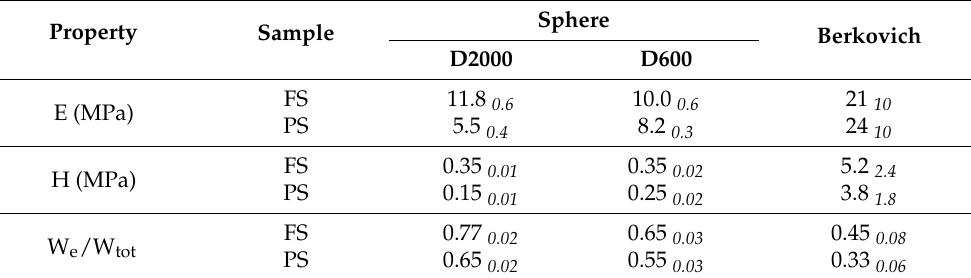
Table 3. Average values and standard deviations of elastic modulus, hardness, and elastic-to-total work ratio determined from indentation tests with spherical and Berkovich tips, using the CSM method. The values of hardness for the D2000 and D600 spherical tests correspond to the end of the elastic domain in the contact stress–strain curves. Numbers in italic stand for the standard deviation.